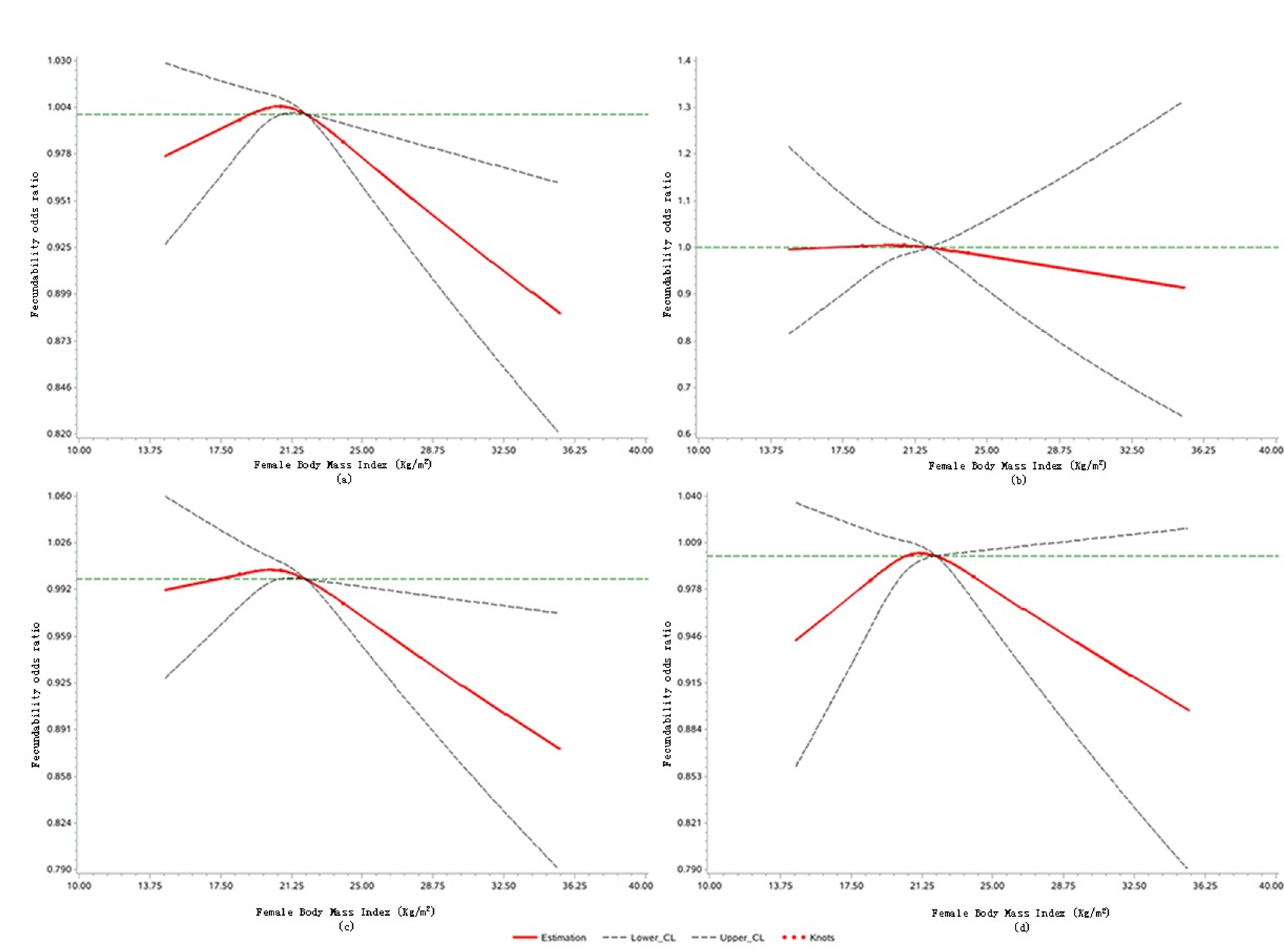
Fig 1. Association between female BMI and fecundability odds ratio, fitted by restricted cubic splines. (a) All pregnant women; (b) Pregnant women with UW spouse; (c) Pregnant women with NW spouse; (d) Pregnant women with OW/OB spouse. Knots are located at 18.5, 20.7, and 24.0 kg/m 2 . Reference level for FOR = 22 kg/m 2 . Reference line is Y = 1. The curves are adjusted for female age (categorical), type of household, education, smoking, alcohol consumption, psychosocial pressure, ready for pregnancy, cycle regularity, and age of menarche, gravidity, and spontaneous and induced